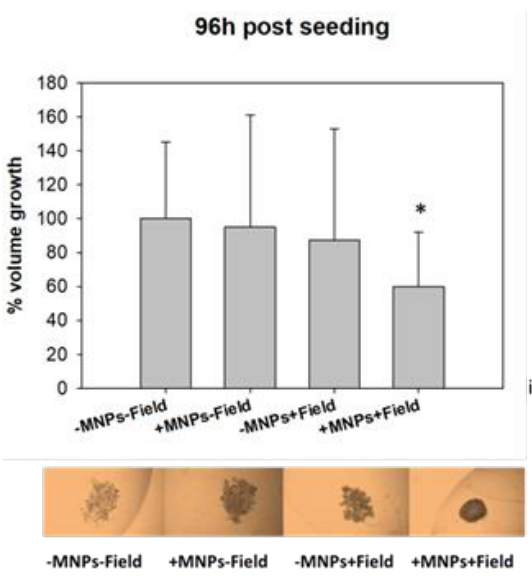
Figure 4. Effect of magnetomechanical stress on the growth of tumor spheroids. Percentage of volume growth is expressed relative to the growth of control cells ( − MNPs − Field) and refers to the difference in spheroids’ volume between Day 0 and Day 4 post seeding. HT29 cells were seeded 24 h after the magnetic field exposure. ( i ) Spheroids’ volume growth at 96 h post seeding expressed as % relative to control. Data presented as means ± SD. ( ii ) Photographs of representative spheroids captured at 96 h post seeding. At least 10 ( n = 10) spheroids were analyzed. * Asterisk indicates a statistically significant difference (Student’s t -test, p ≤ 0.05).